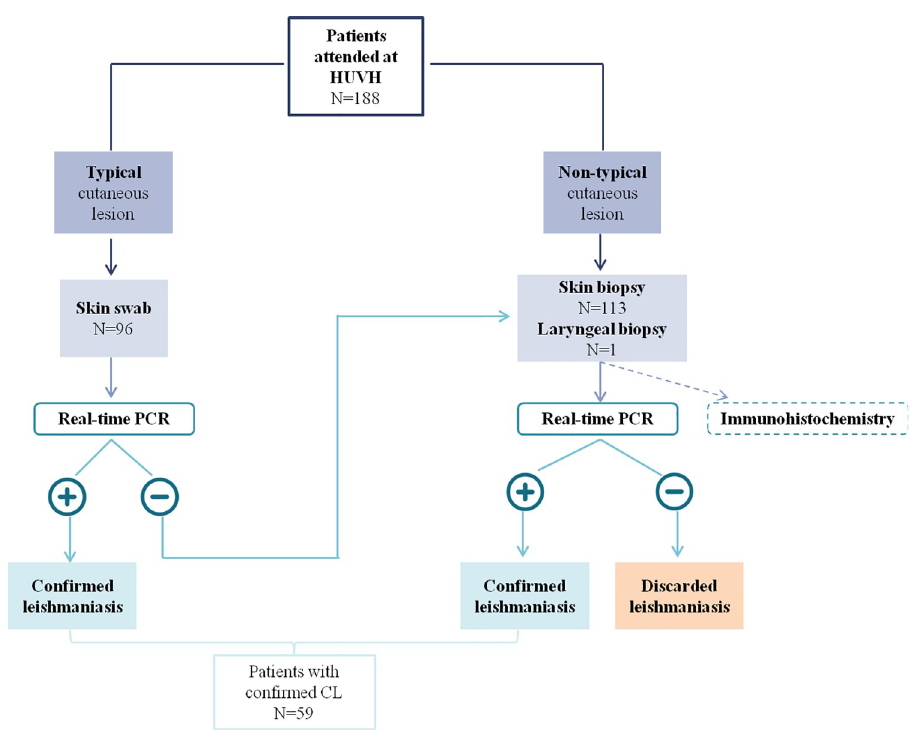
Fig 1. Algorithm of the samples used in this study and which assays were